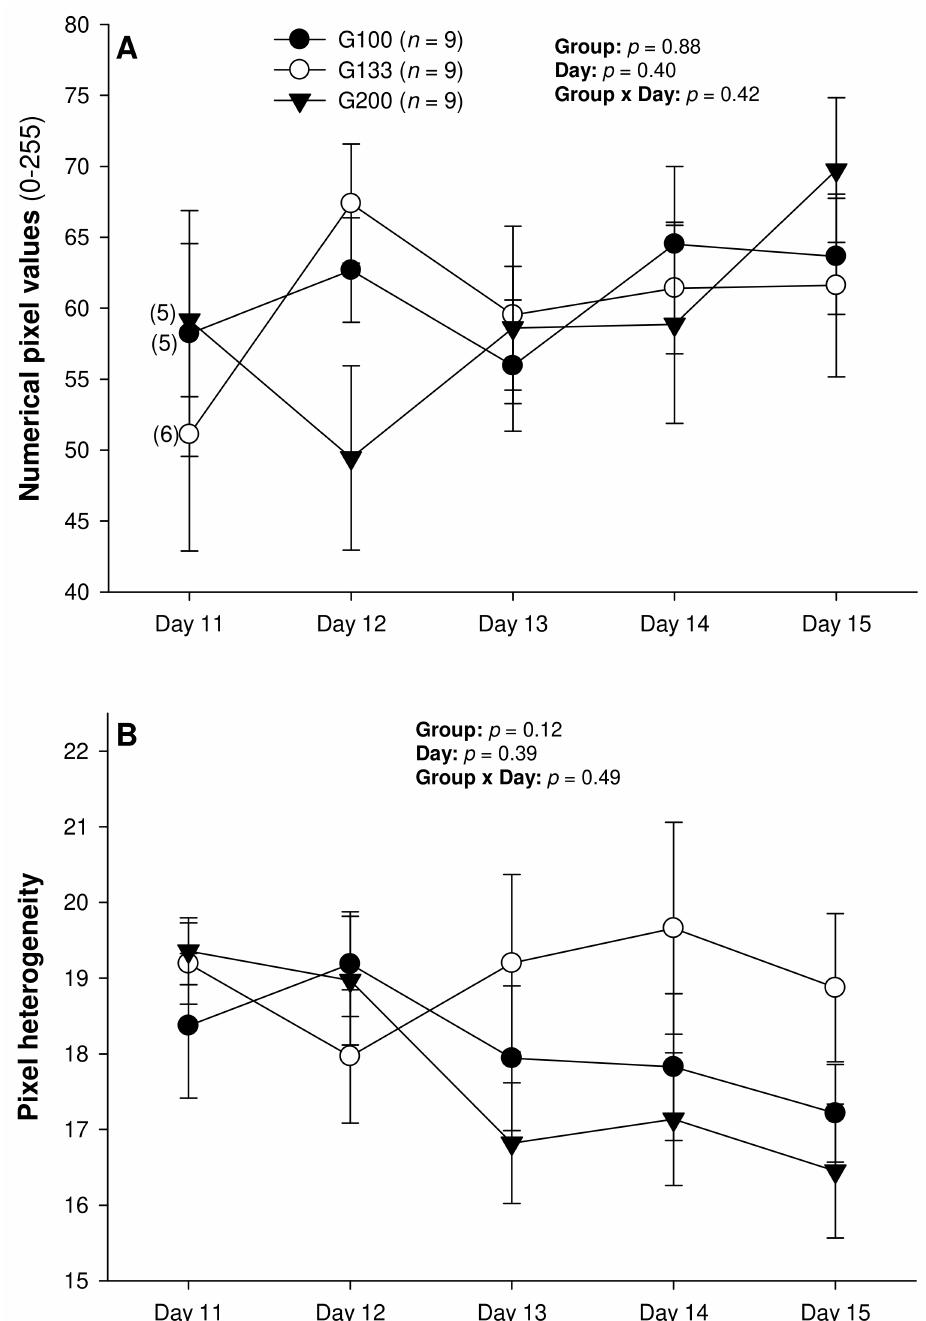
Figure 2. Mean ( ± SEM) numerical pixel values ( A ) and heterogeneity ( B ) of CL ultrasonographically detected from Day 11 (1 or 2 days after ovulation or beginning of luteogenesis) to Day 15 (day of embryo recovery) of the superovulatory protocol in Santa In ê s ewes superovulated with 100 (G100), 133 (G133), or 200 (G200) mg of pFSH given in eight decreasing doses. Numbers in parentheses (panel A ) denote the numbers of ewes in which CL were detectable ultrasonographically on Day